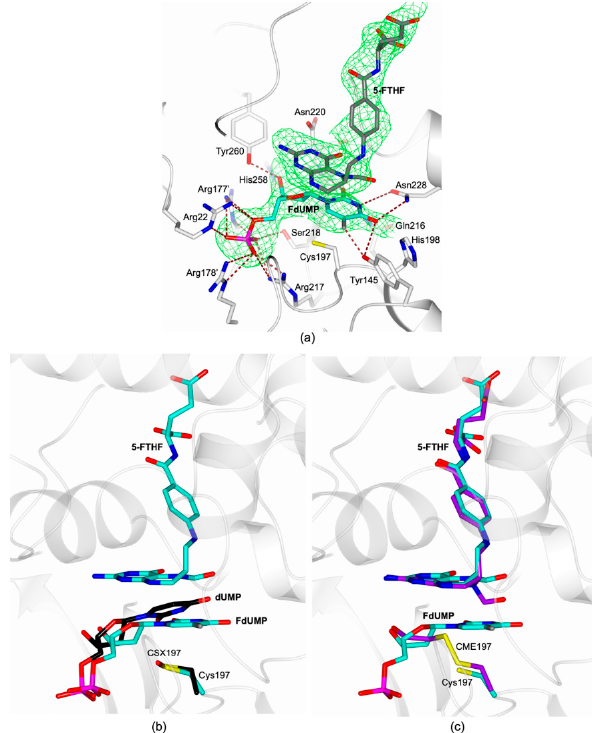
Figure 5. ( a ) Active site view of Ef TS (white cartoon and carbon atoms) in complex with FdUMP (in sticks, cyan carbons) and 5-FTHF (in sticks, dark grey carbons). In the panel, FdUMP and 5-FTHF are surrounded by their omit map (green mesh) contoured at the 2.5 σ level. Key interactions (salt bridges, hydrogen and halogen bonds) are displayed as tan dashed lines. ( b ) View of the active site of Ef TS in complex with dUMP (dUMP and CSX197 in sticks, black carbons) superimposed to the Ef TS-FdUMP-5-FTHF complex (FdUMP, Cys197, and 5-FTHF in sticks, cyan carbons). ( c ) View of the active site of the Ef TS–FdUMP-5-FTHF complex (FdUMP, Cys197, and 5-FTHF in sticks, cyan carbons) superimposed to the substrate-free Ef TS (PDB id 3UWL, [5]; Cys197 modified as S , S -(2-hydroxyethyl)thiocysteine, CME-197 and 5-FTHF in sticks, purple carbons). Fluorine atoms are colored